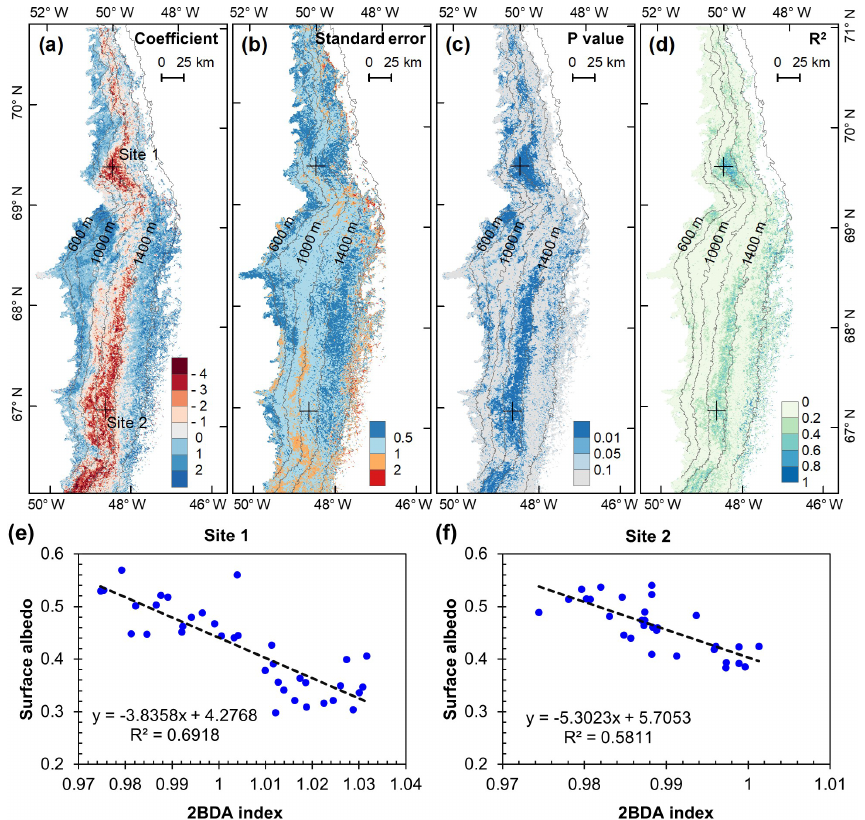
Figure 10. Relationship between surface albedo and 2BDA index: (a) regression coefficients, (b) Standard errors of the correlation coeffi- cients, (c) p values, and (d) R 2 values. Panels (e, f) show surface albedo vs. 2BDA index at Site 1 and Site 2,